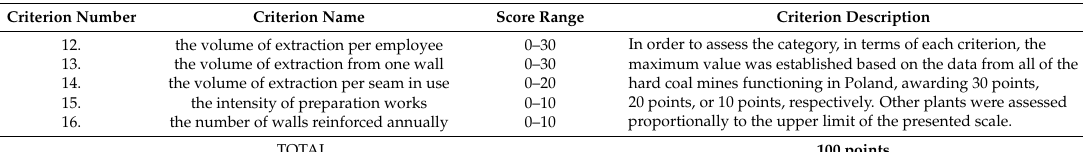
Table 3. Principles for assessing production